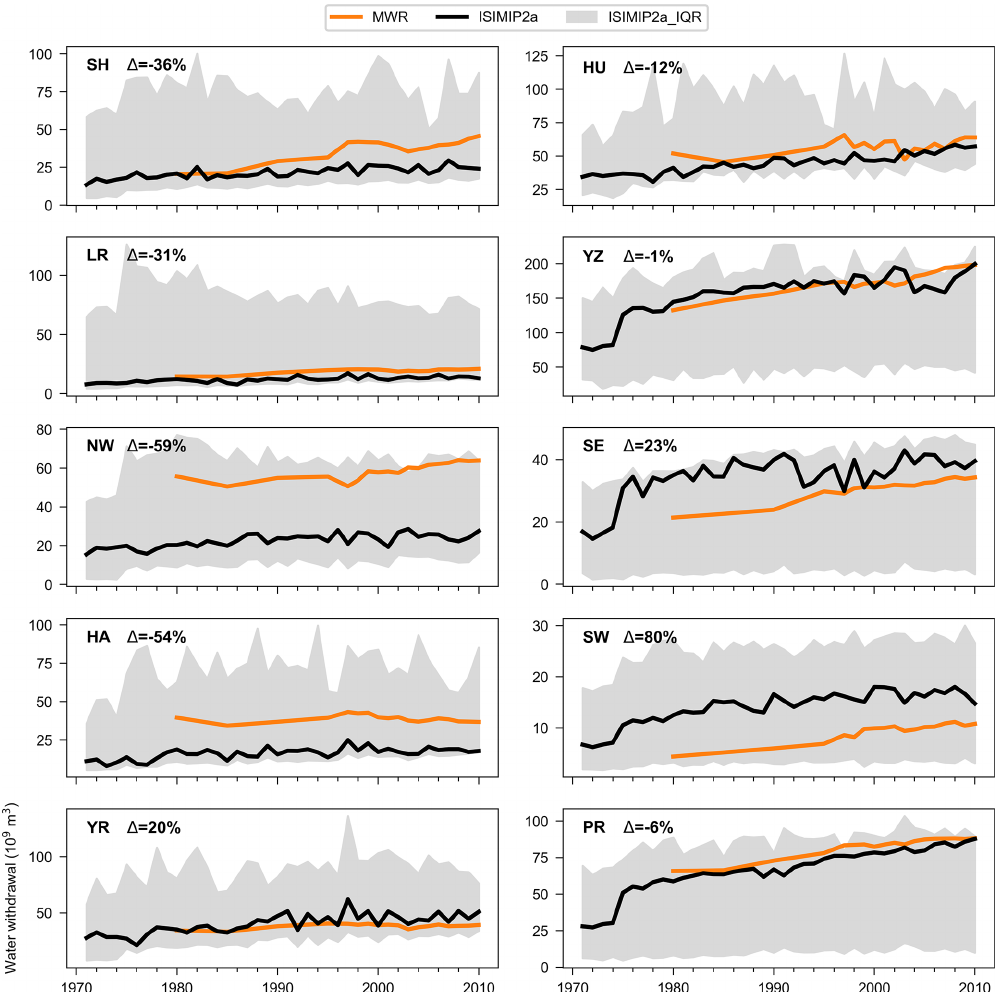
Figure 2. Reported and simulated water withdrawals in the 10 basins of China. ISIMIP2a indicates the simulated water withdrawals from the ISIMIP2a VARSOC experiment (see Table S1 for details) during 1971–2010; MWR indicates the water withdrawals reported by the Ministry of Water Resources (MWR) of China for the years 1980, 1985, 1990, 1995, and 1997–2010. (cid:49) indicates the difference between simulations and reported data. Shaded areas denote the IQR of ISIMIP2a simulations. The basin names labeled in each panel are corresponding to the basins in Fig.